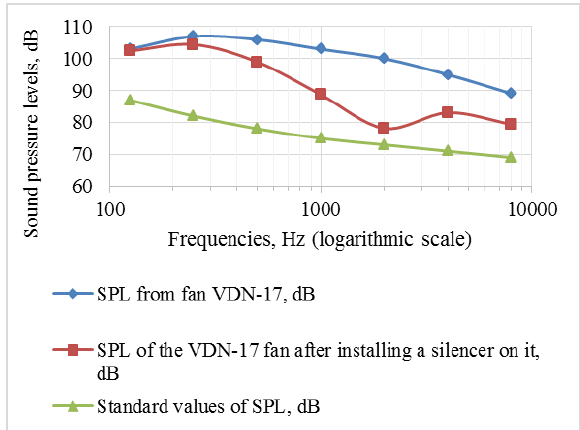
Fig. 1. Noise characteristics in the discharge zone before and after installation of the muffler